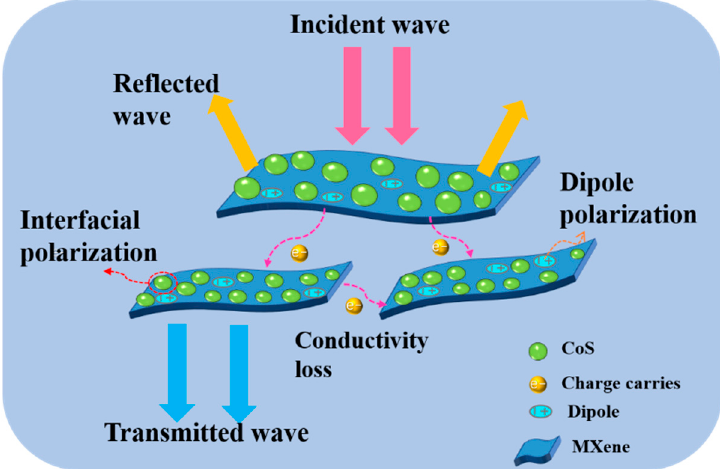
Figure 12. Scheme of EM wave absorbing mechanism of the CoS@Ti 3 C 2 T x composites.